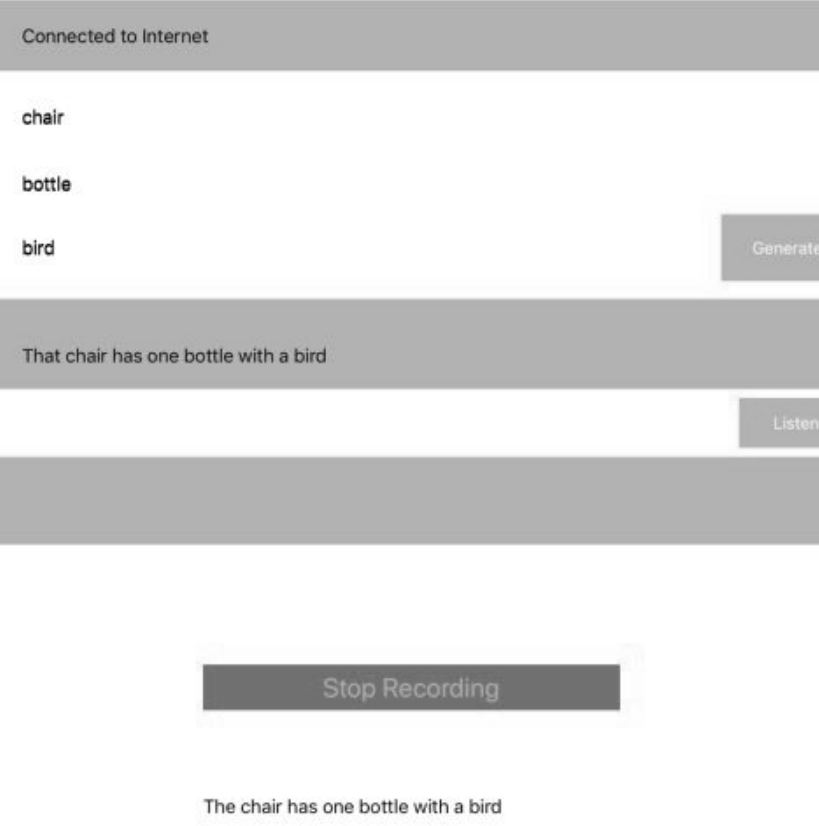
Figure 8. Sufficient software validation for the